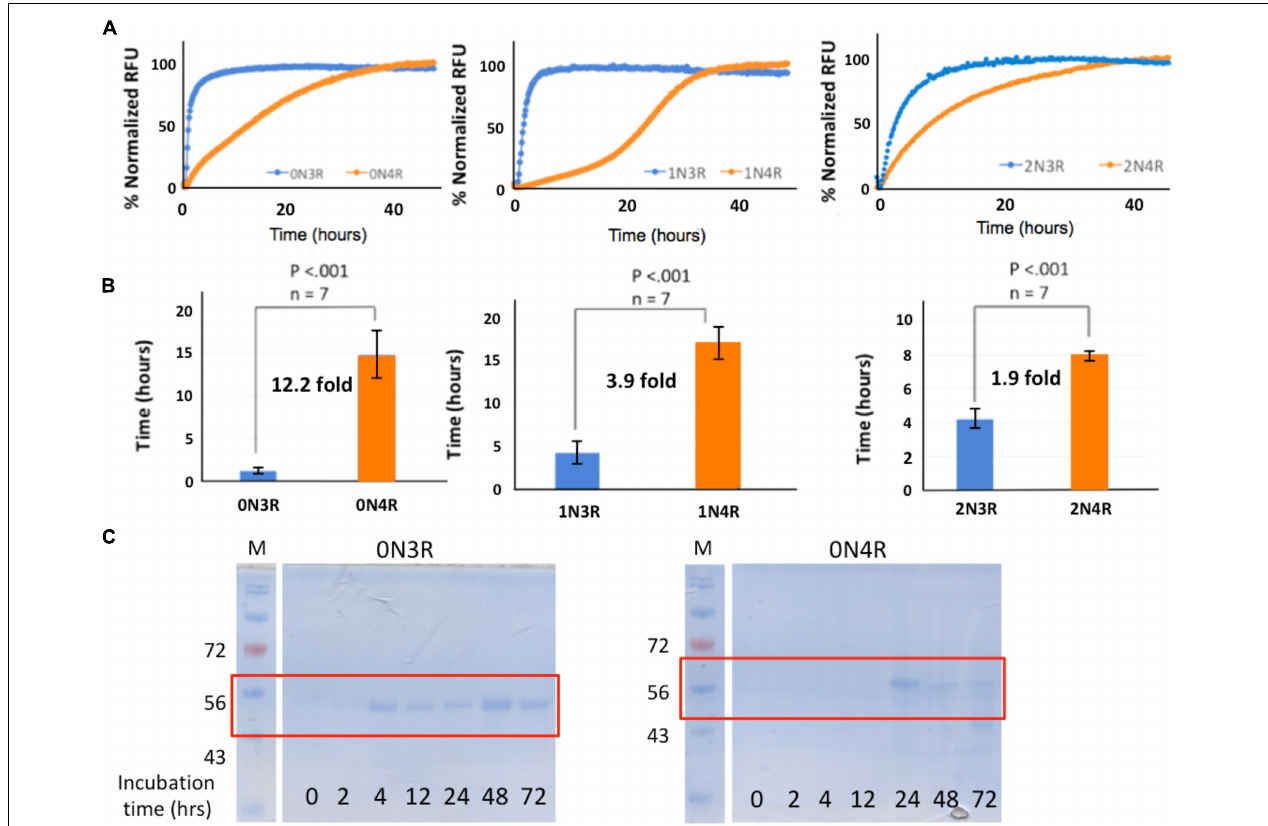
FIGURE 5 | Pair-wise aggregation kinetics comparison of 3R and 4R tau isoforms. (A, B) Quantitative analysis of tau isoform aggregation kinetics using ThT fluorescence-based assays. 30 µ M of 0N3R or 0N4R (Left Panel), 1N3R or 1N4R (Center Panel), and 2N3R or 2N4R (Right Panel) were incubated in 20 mM Tris pH 7.4 with 0.06 mg/ml of heparin at 37 ◦ C for specified time periods. Kinetic fluorescence traces are shown in panel (A) . Corresponding t 1 / 2 values for each aggregation kinetics curves are shown in panel (B) . (C) Aggregation kinetics comparison of 0N3R and 0N4R isoforms by Sarkosyl-insoluble tau pelleting assay. 30 µ M of 0N3R or 0N4R were incubated in 20 mM Tris pH 7.4 with 0.06 mg/ml of heparin at 37 ◦ C for specified time periods. Aggregated tau isoforms (Sarkosyl-insoluble tau) were visualized by SDS-PAGE after Commassie Blue